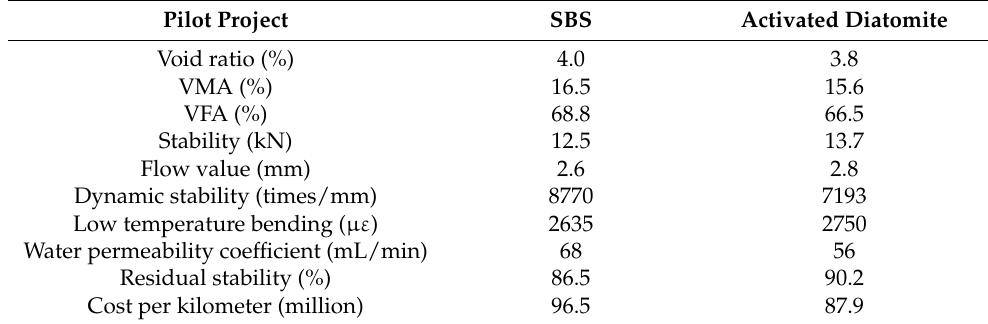
Table 6. Performance comparison of SBS and activated diatomite modified asphalt